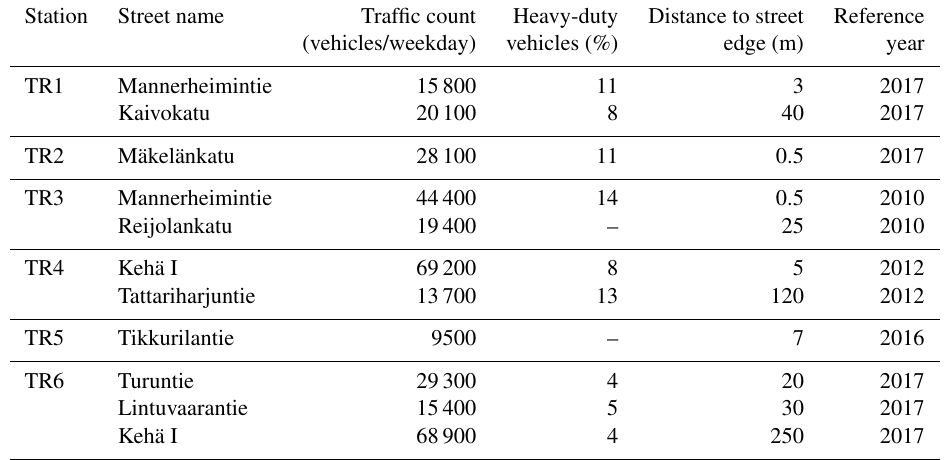
Table 2. Traffic counts for working days at the nearest streets to the TR sites. Traffic counts and the fraction of the heavy-duty vehicles are from the yearly Helsinki traffic reports. The streets and roads mentioned here are marked in Fig. S3. Station Street name Traffic